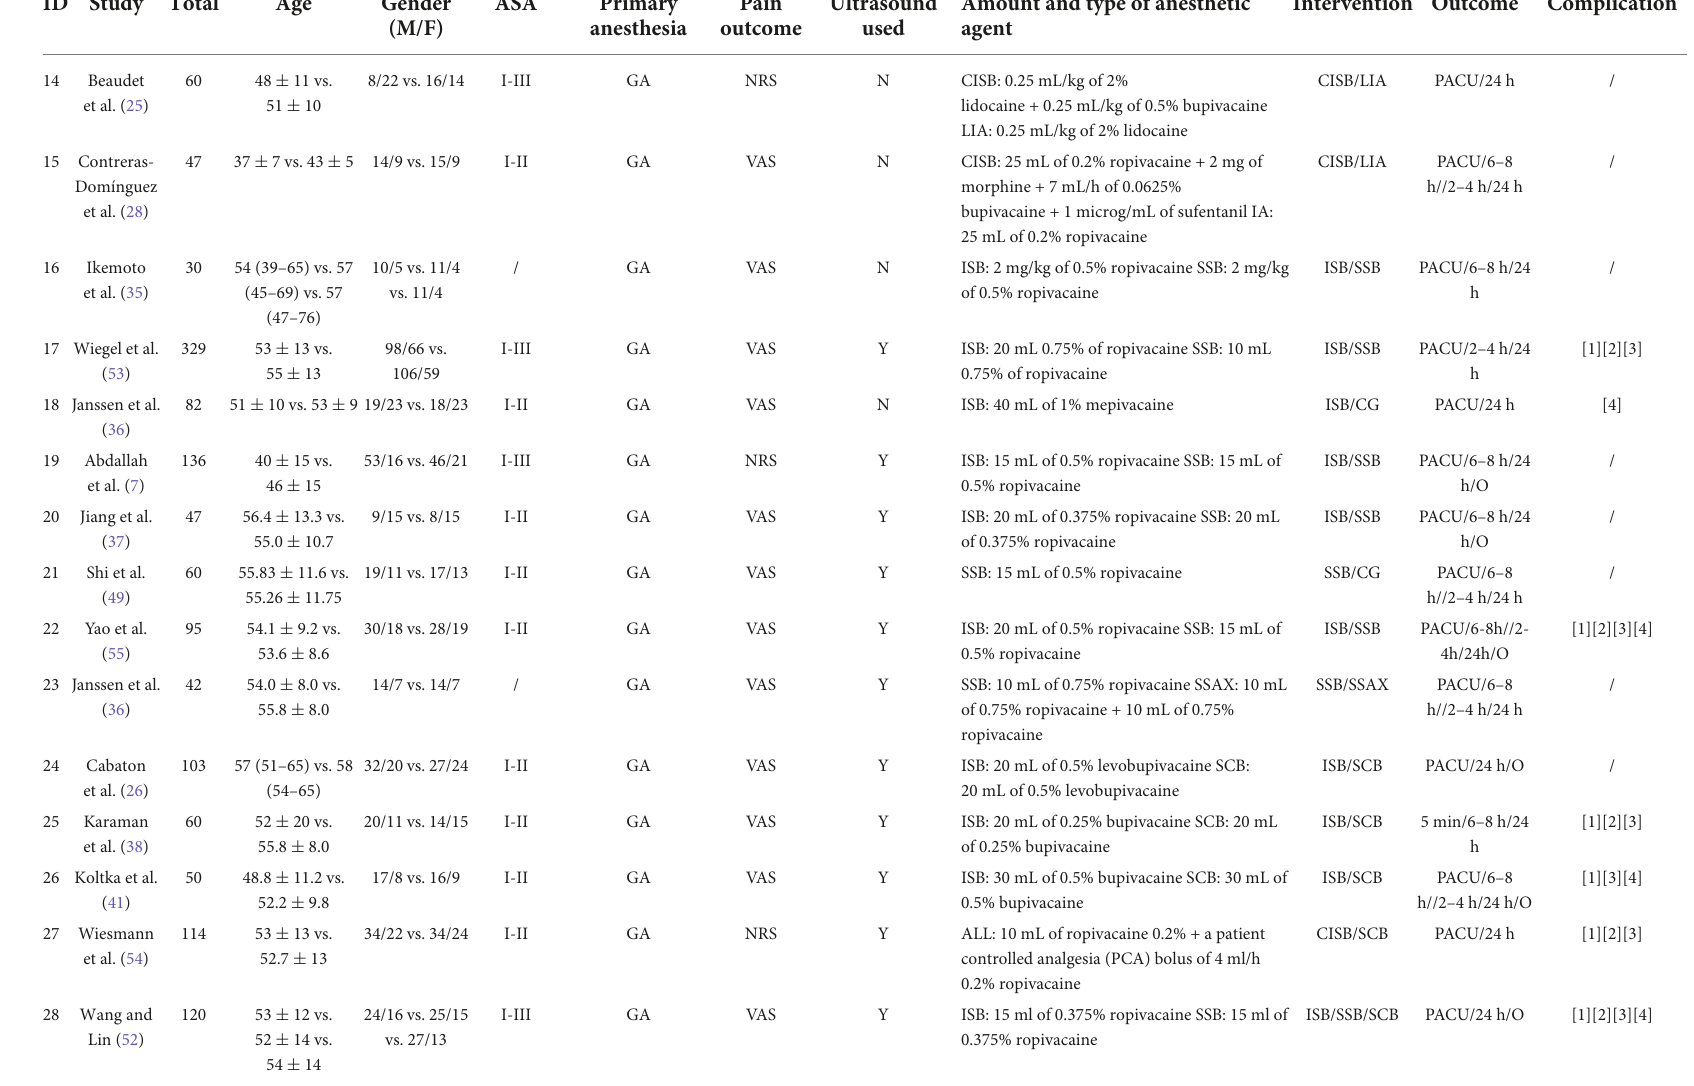
Y ALL: 10 mL of ropivacaine 0.2% + a patient controlled analgesia (PCA) bolus of 4 ml/h 0.2% ropivacaine ISB: 15 ml of 0.375% ropivacaine SSB: 15 ml of 0.375%